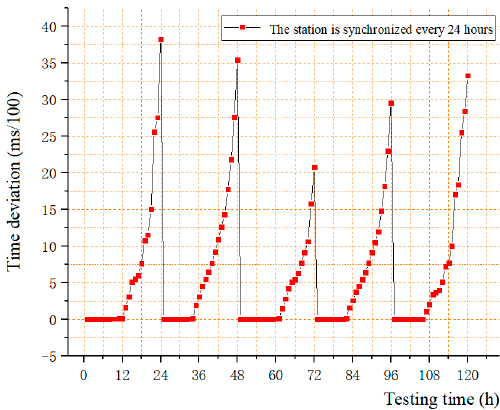
Figure 12. The results of synchronous accuracy test (the slave is synchronized every 24